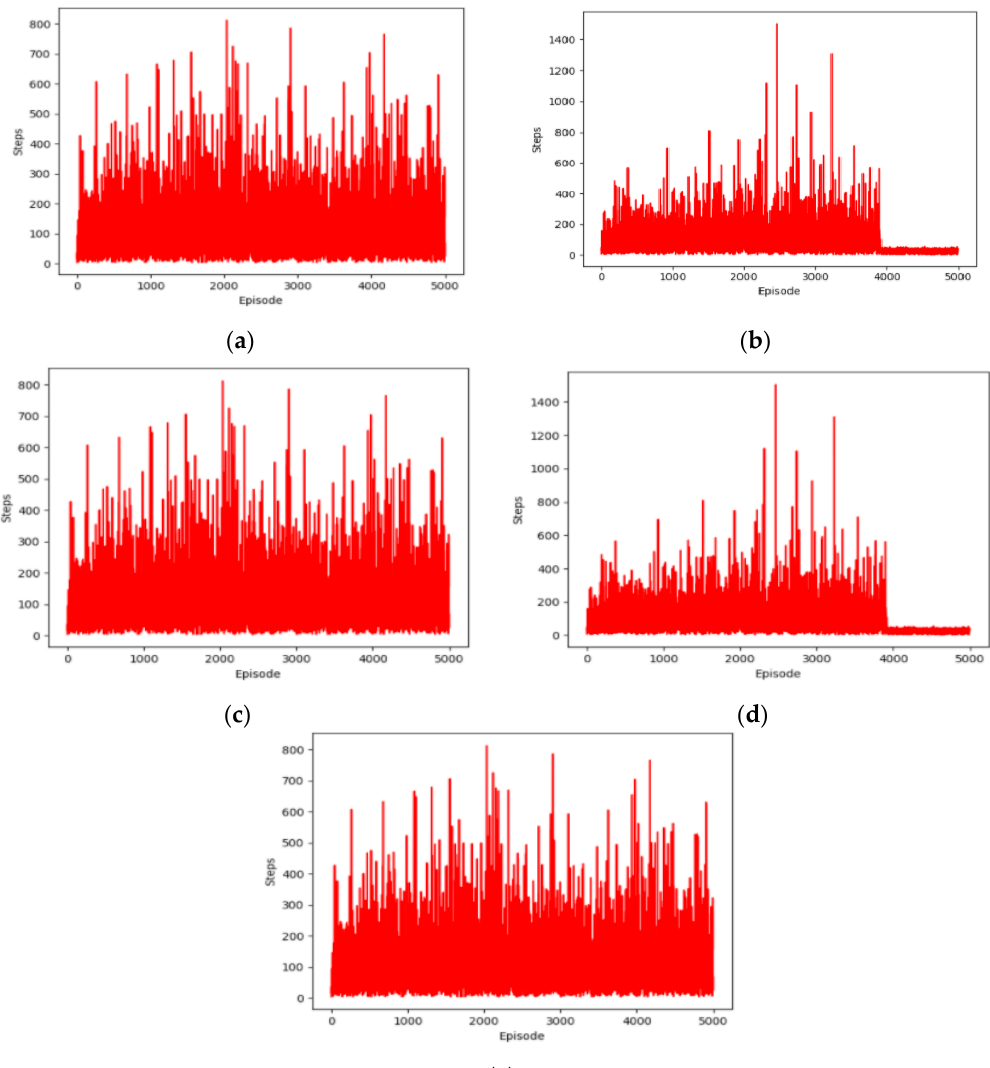
Figure 11. Path optimization learning progress status of Q-Learning: ( a ) 1st test; ( b ) 2nd test; ( c ) 3rd test; ( d ) 4th test; ( e ) 5th test.